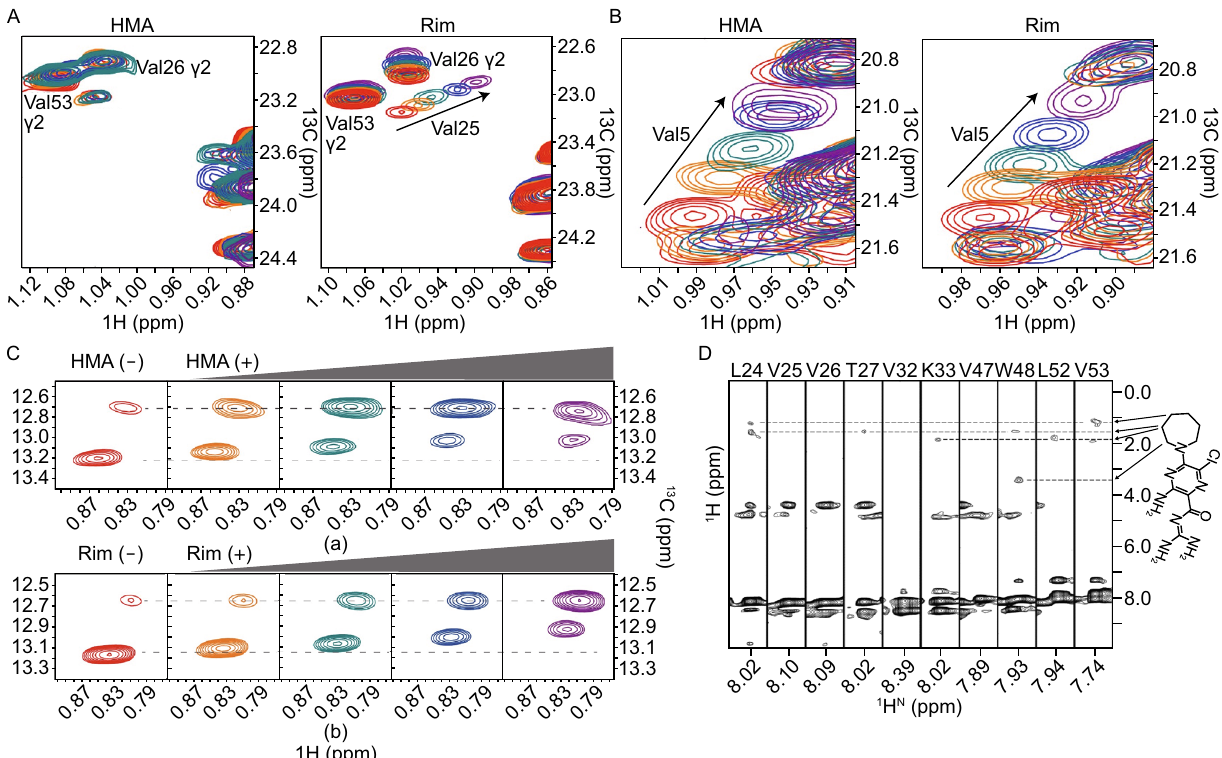
Figure 1. NMR characterization of HMA binding site . (A – C) Rimantadine and HMA titrations using 1 H- 13 C HSQC as a readout. Uniformly ( 13 C, 15 N)-labeled p7 (5a) (monomer concentration at 0.1 mmol/L) reconstituted in 20 mmol/L DPC was titrated with 0 (red), 1 (orange), 2 (green), 4 (blue), and 8 mmol/L (purple) rimantadine and HMA. Spectra were recorded on a 600 MHz spectrometer. The resolved peaks are labeled with assignments and the arrows indicate the movement of peaks. Shown in the boxes are gamma methyl resonances of Val25 (A), gamma methyl resonances of Val5 (B), and delta methyl resonances of Ile6 (C). (D) NOESY experiment identifying the binding site. Representative strips from the three-dimensional 15 N-edited NOESY-TROSY-HSQC spectrum (300 ms NOE mixing time) recorded using a sample containing ( 2 H, 15 N)-labeled p7 (5a) and 2 mmol/L HMA, showing HMA NOEs to